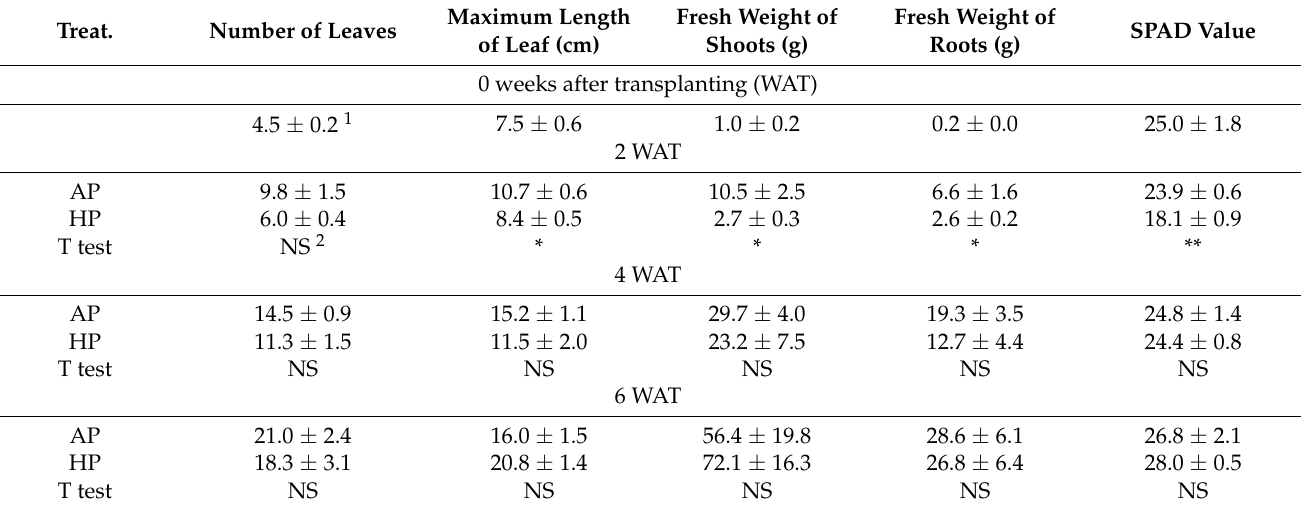
Table 2. Growth of lettuce plants in aquaponics (AP) and hydroponics (HP) in Exp. 2.